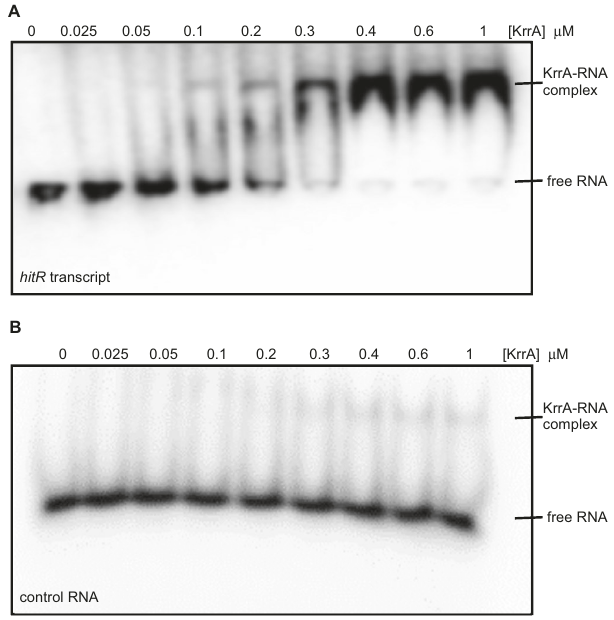
Fig. 4 KrrA binds to hitR transcript in vitro. A , B To examine whether KrrA binds to hitR transcript in vitro, an electrophoretic mobility gel shift assay was carried out using in vitro-transcribed and radioactively labeled hitR transcript ( A ) and control RNA ( B ) in the presence of increasing concentration of KrrA protein as indicated. The experiments were conducted at least three times and representative images are